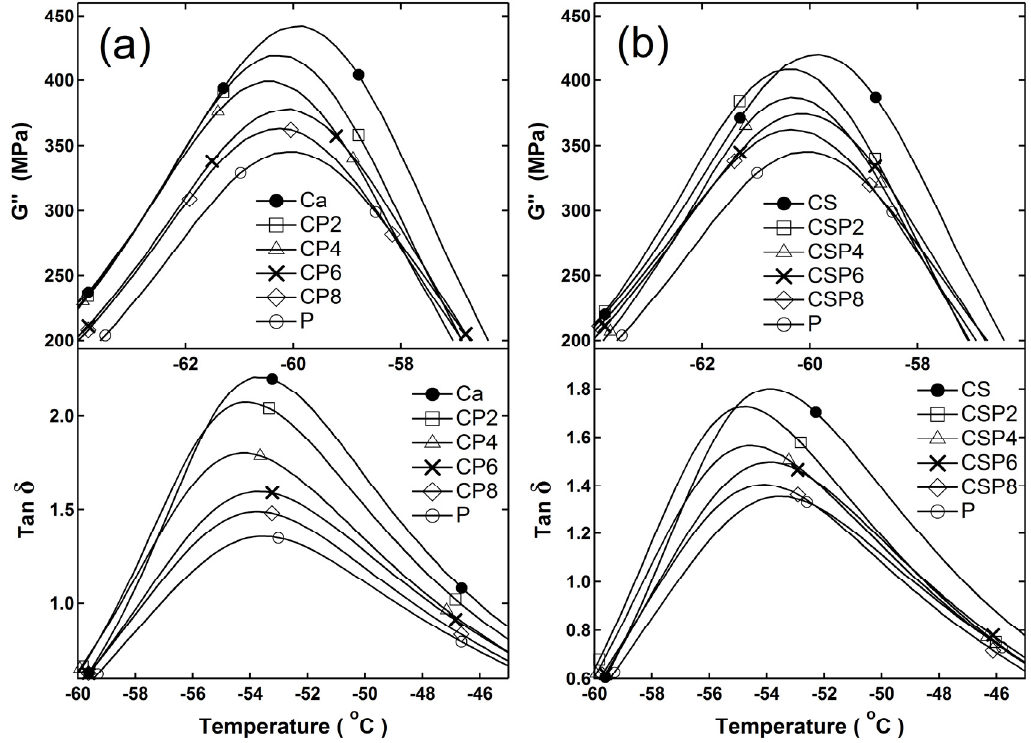
Figure 3. Loss moduli and loss tangent for modified and unmodified rubber composite. ( a ) CaCO 3 . ( b ) CaCO 3 modified with stearic acid.